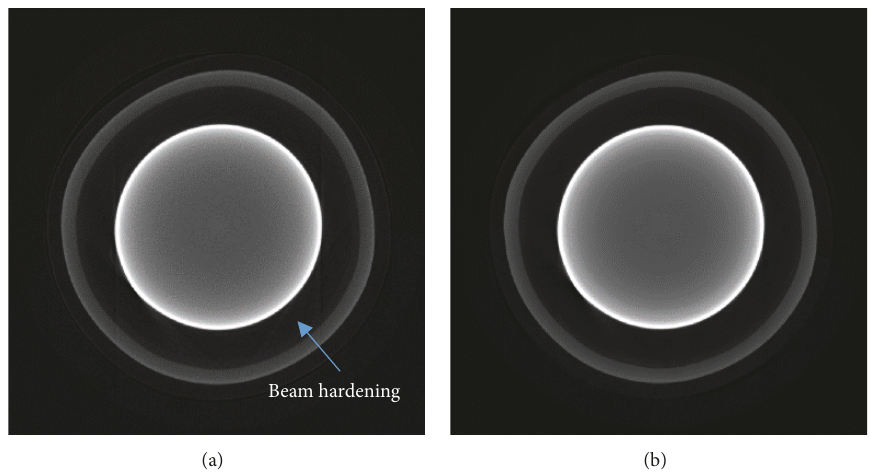
Figure 1: (a) CT raw data image and (b) CT slice after using edge-preserving filter.